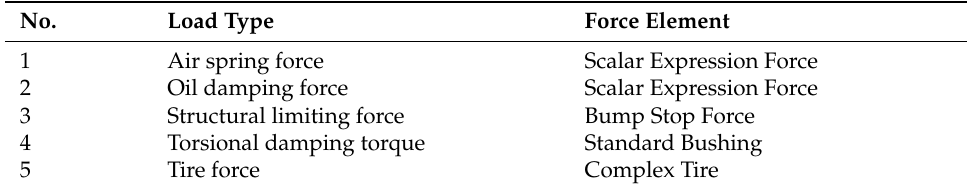
Table 1. Summary of load application.